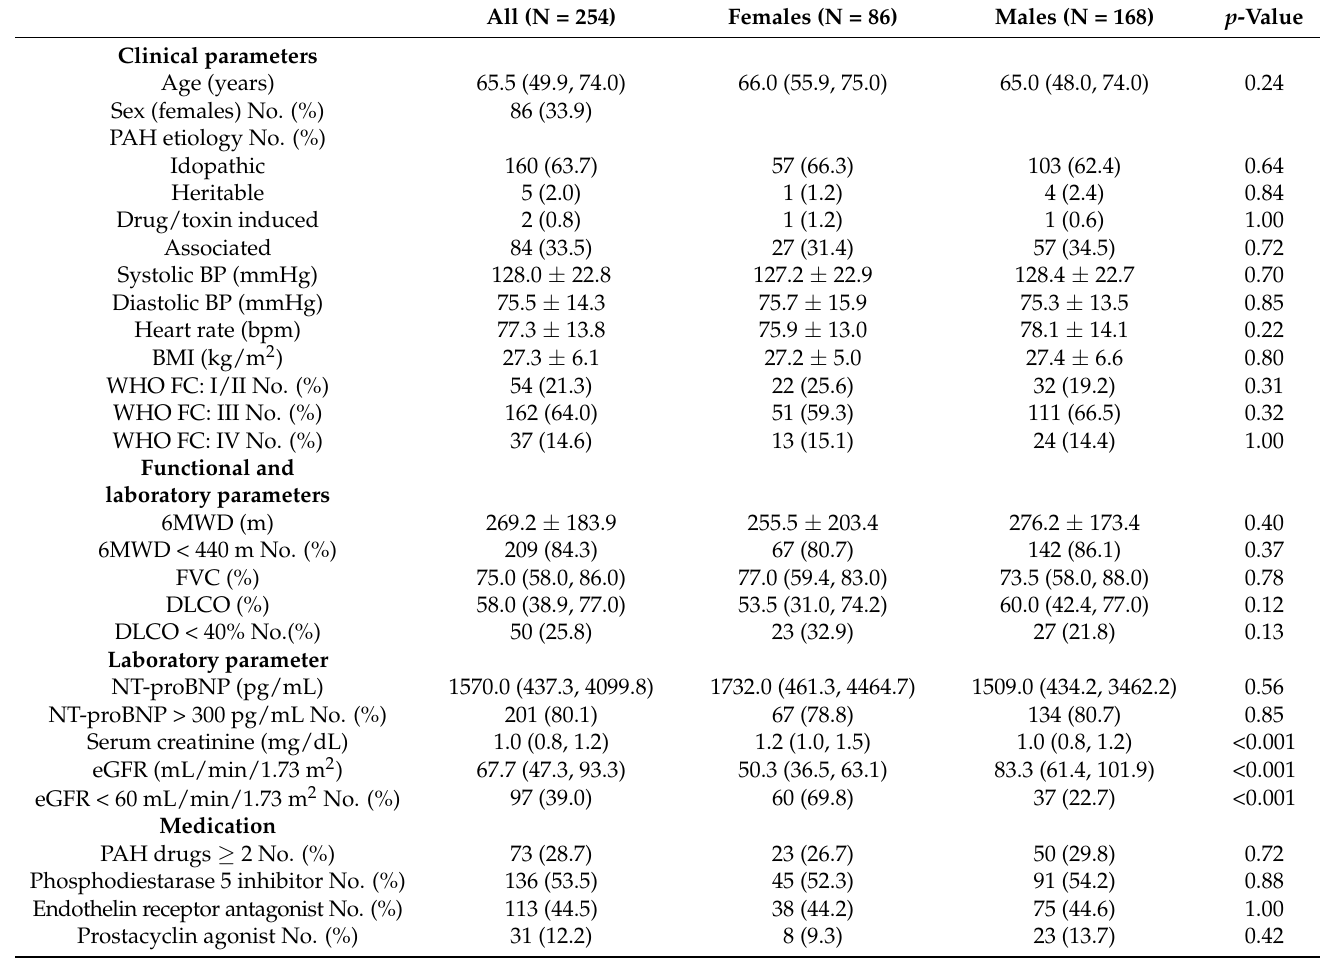
Table 1. Baseline characteristics of the overall study